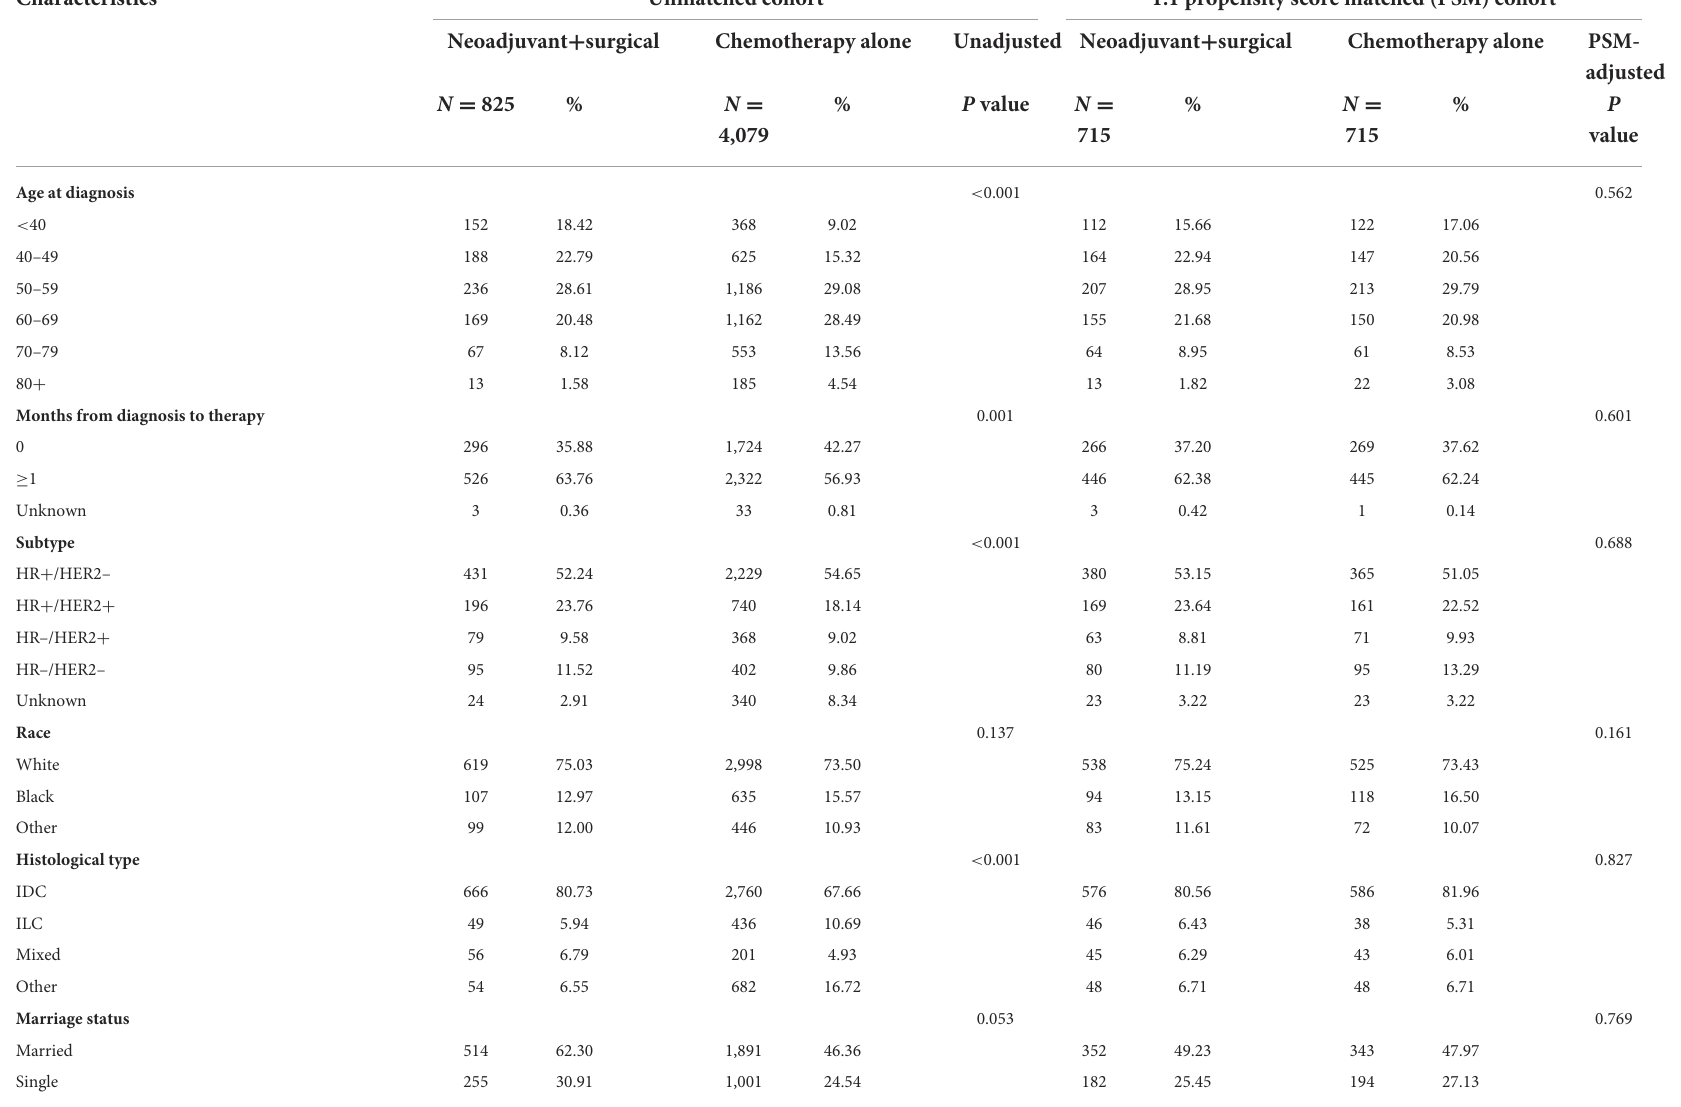
TABLE 3 Comparison of patient characteristics according to the use of neoadjuvant chemotherapy before and after propensity score matching (PSM).